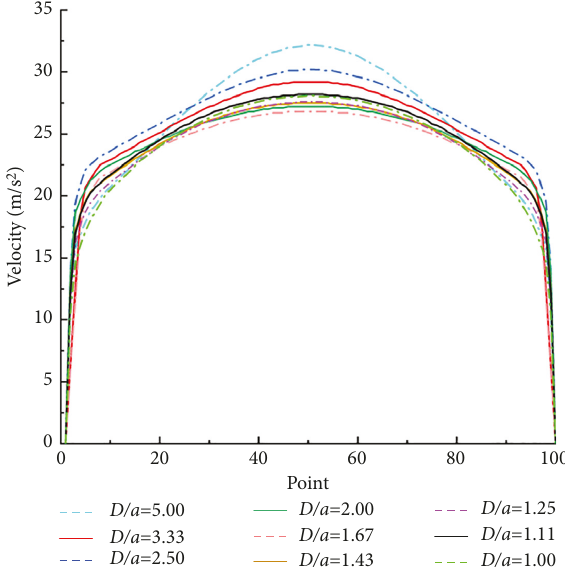
Figure 15: Velocity distribution of dual-chamber self-excited oscillating pulsed nozzles.